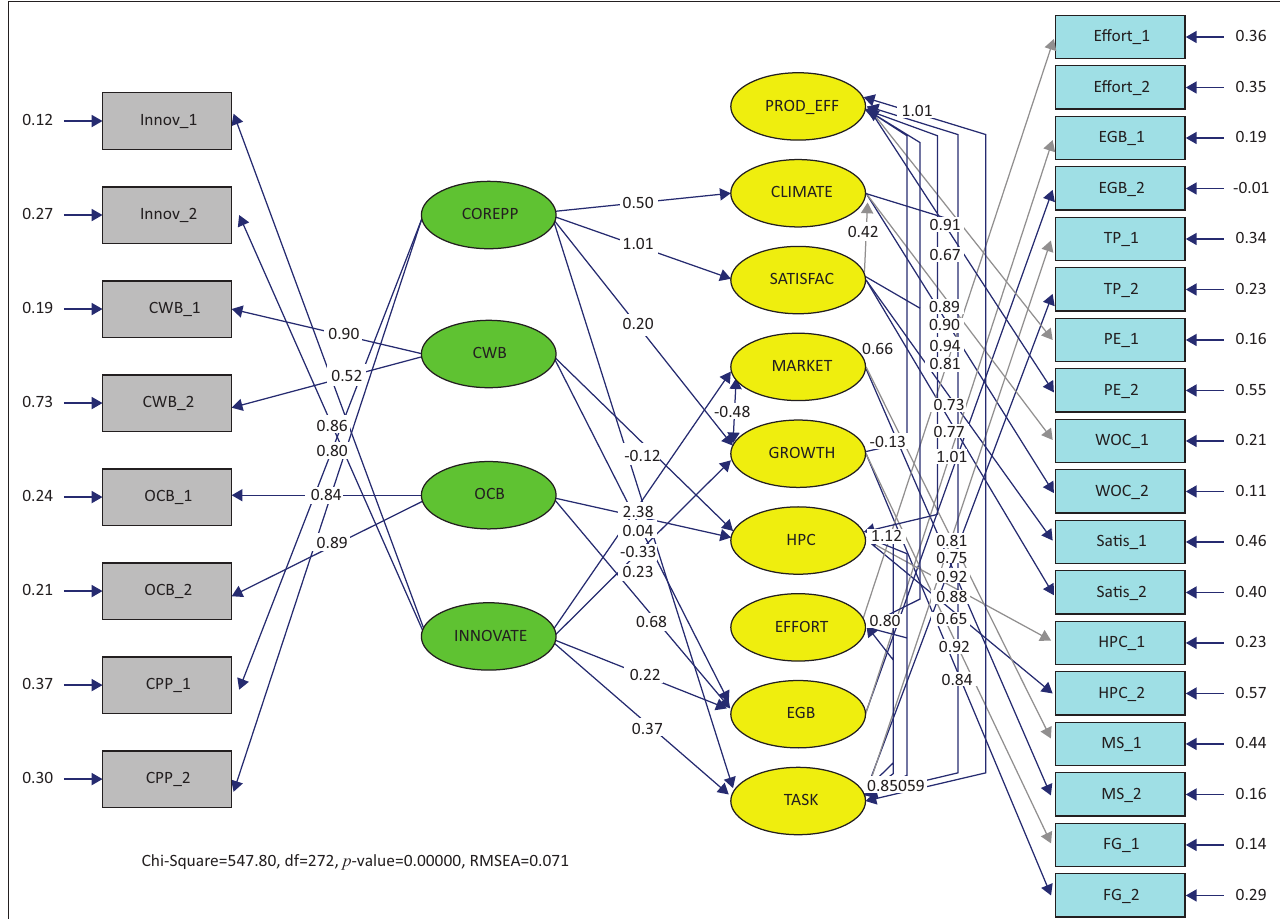
FIGURE 2 : Representation of the revised fitted comprehensive work unit performance LISREL model (completely standardised